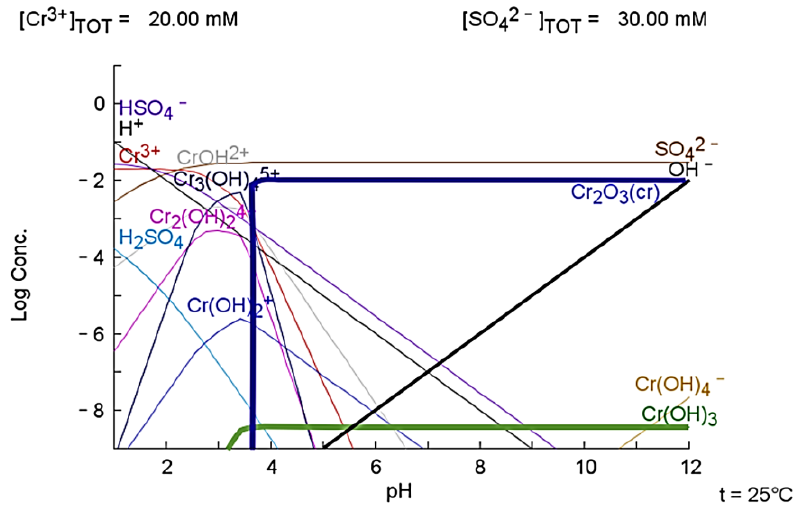
Figure 7. Simulated plots of the aqueous chemistry in 0.01 M Cr 2 (SO 4 ) 3 solution at room tempera- ture.